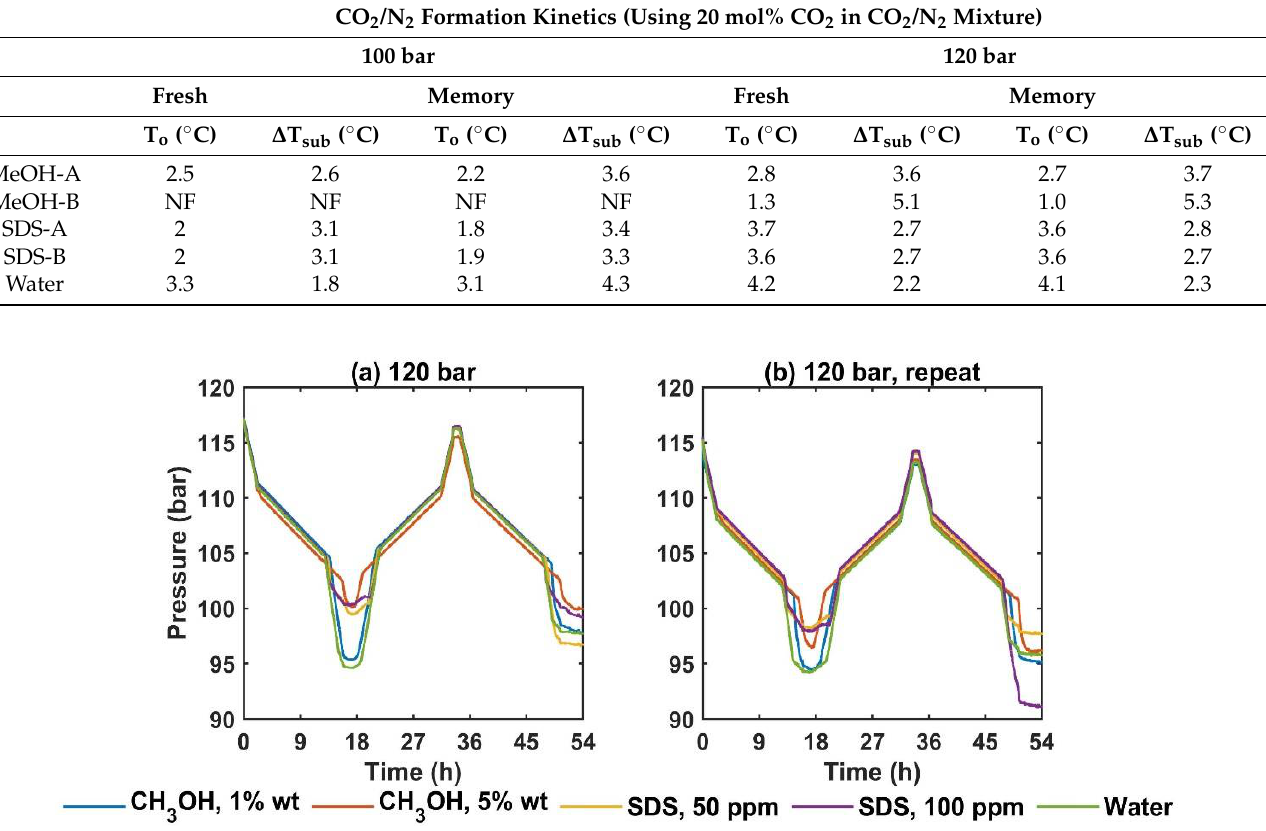
Figure 9. Pressure profiles during the constant ramping temperature scheme in the presence of MeOH, SDS, and water at 120 bar. Starting temperature 25 °C and final temperature 1 °C. Temper- ature ramping rate 1 °C/h between 15 °C–1 °C. ( a , b ) starting pressure 120 bar, fresh, and repeat the experiment.